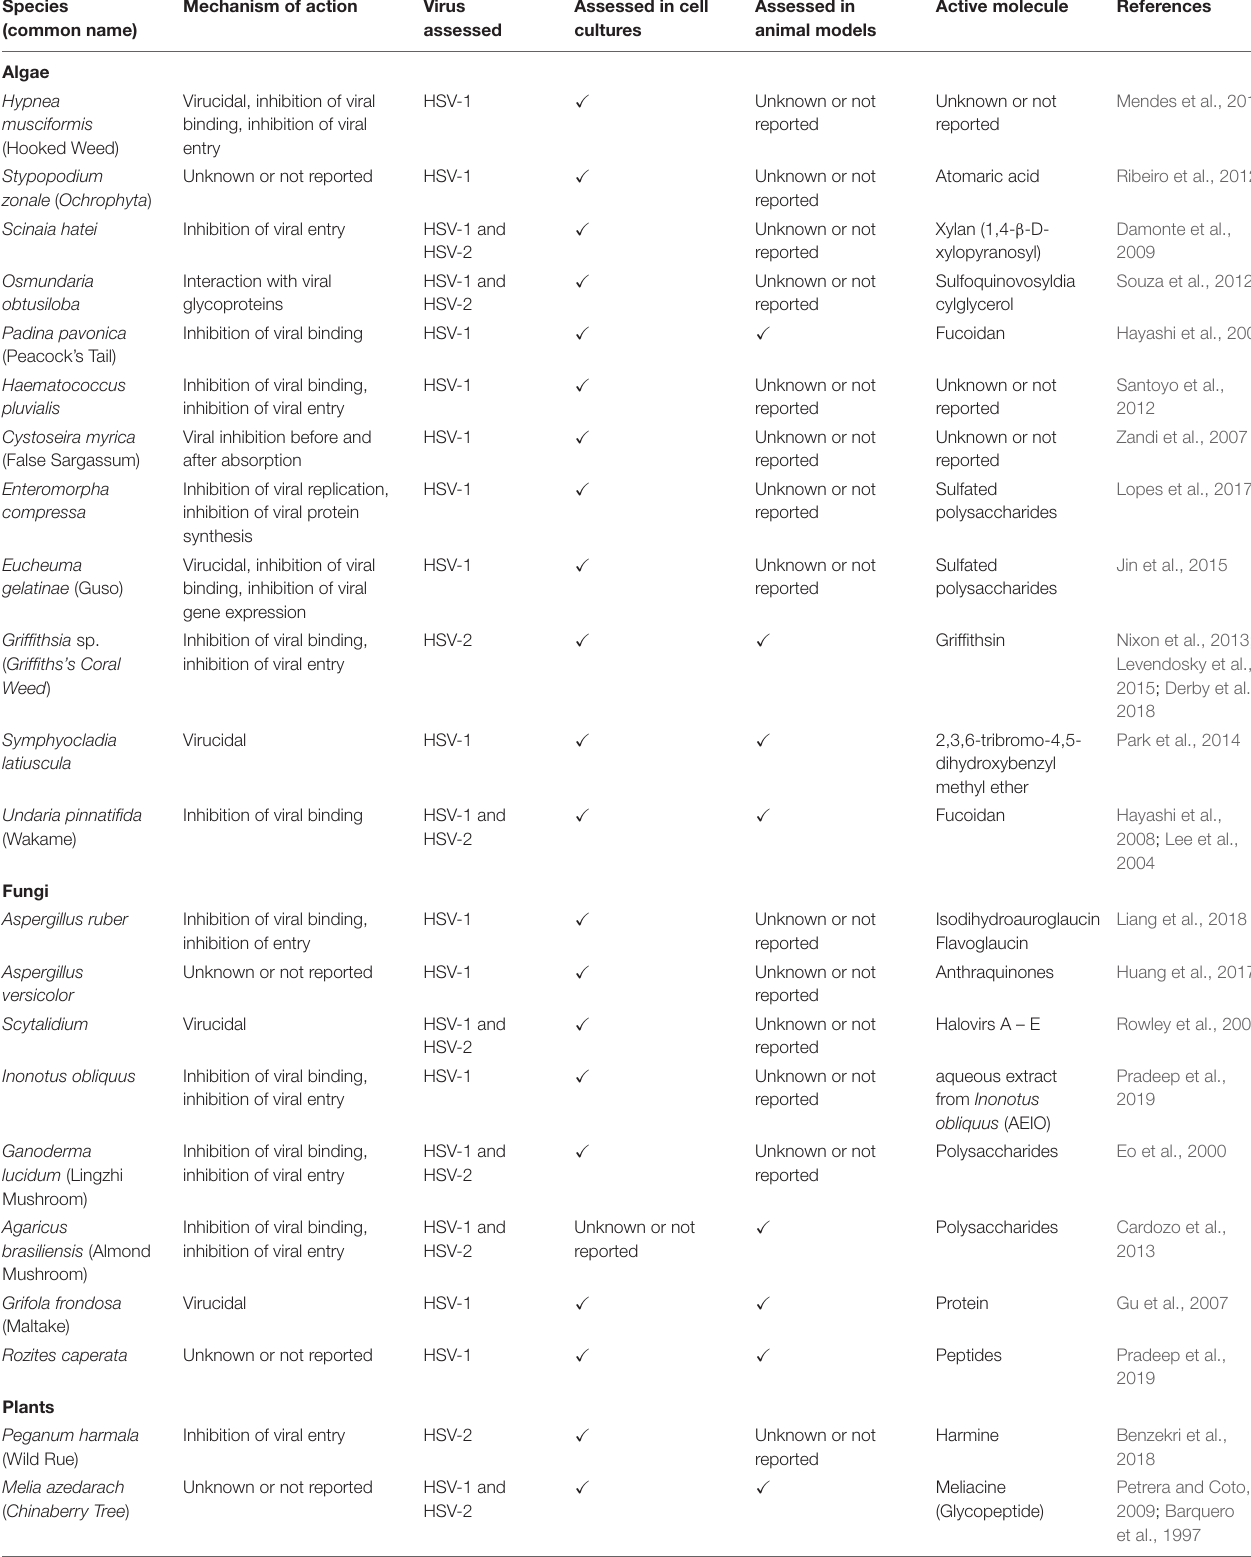
TABLE 2 | Botanical compounds and extracts with antiviral activity against HSV-1 and